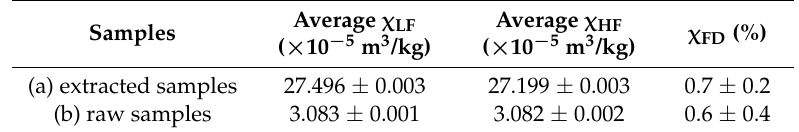
Table 1. Magnetic susceptibility of the extracted samples compared with the raw